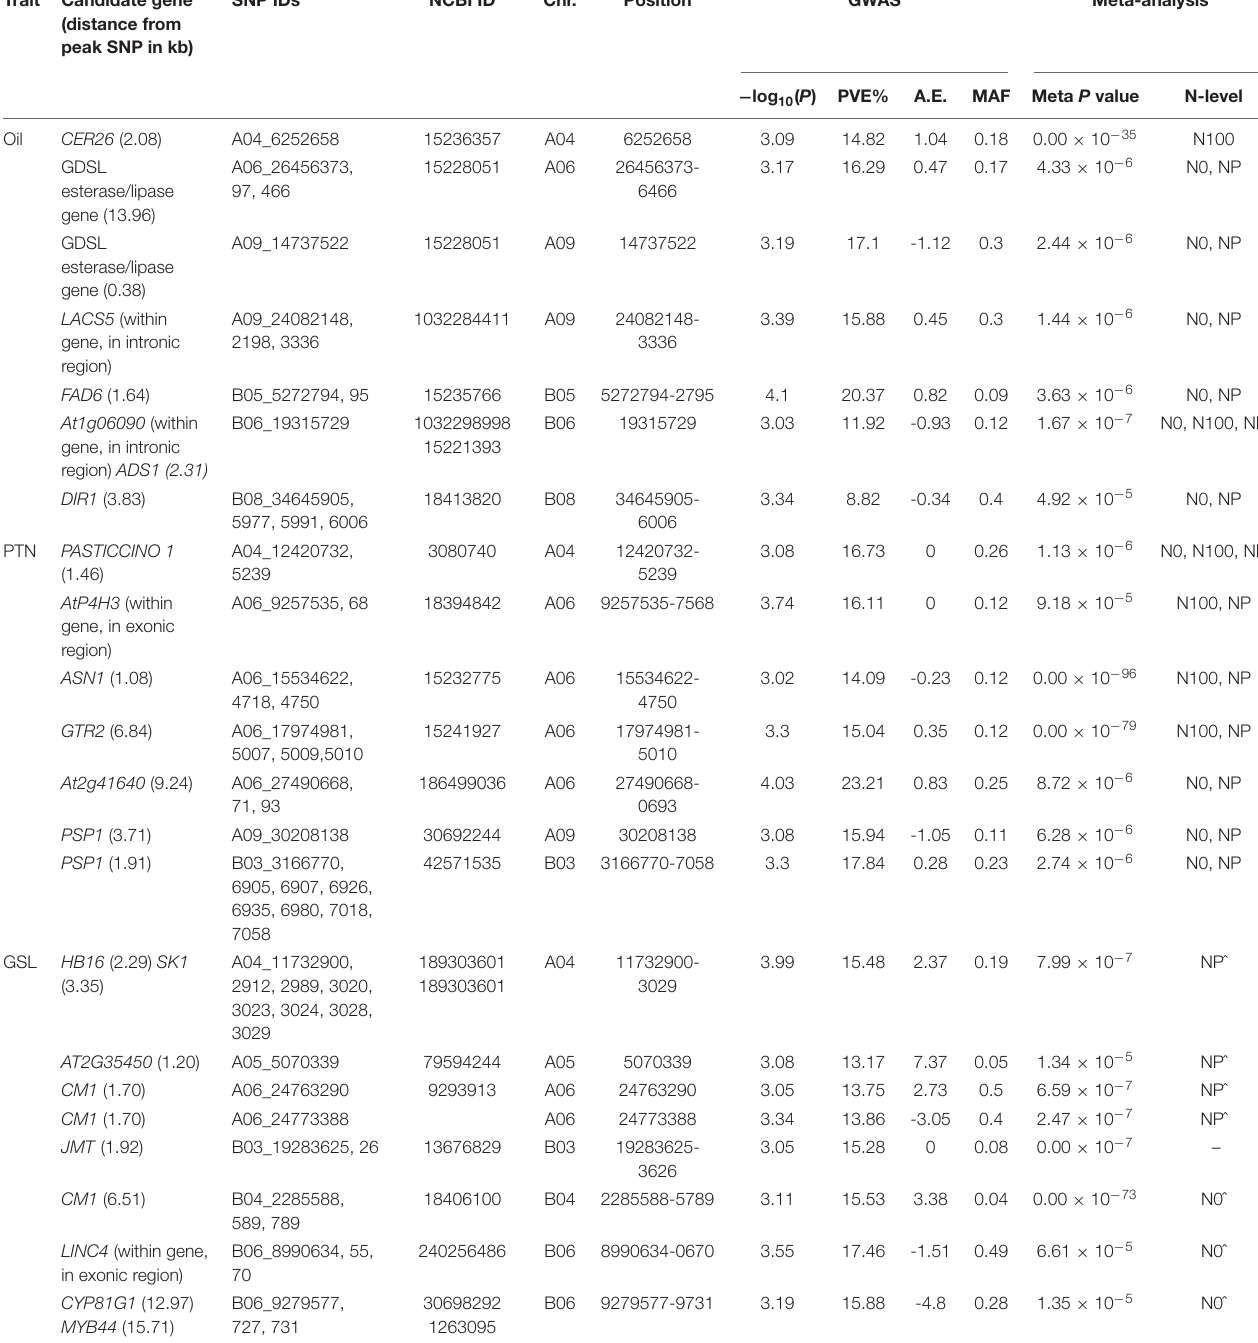
TABLE 2 | Summary of significant SNPs observed for quality traits of the diversity panel in GWAS and meta-analysis. Trait Candidate gene SNP IDs NCBI ID Chr. Position GWAS Meta-analysis (distance from peak SNP in kb)